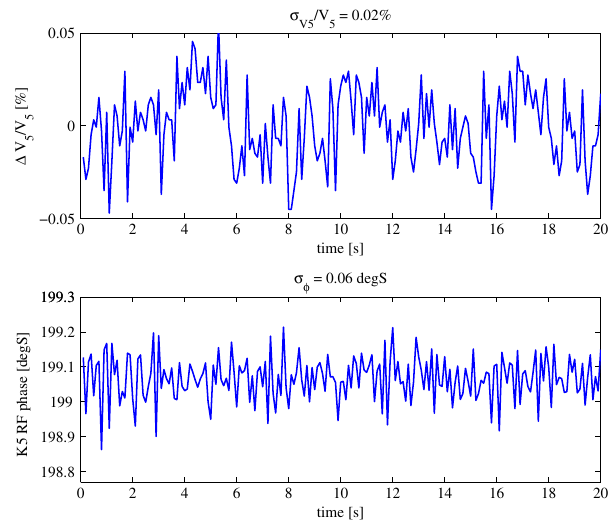
FIG. 6. The relative rf amplitude (top) and rf phase jitter (bottom) of the K5 klystron in L1 rf section measured over 20 sec at a 10 Hz sample rate (feedback active).